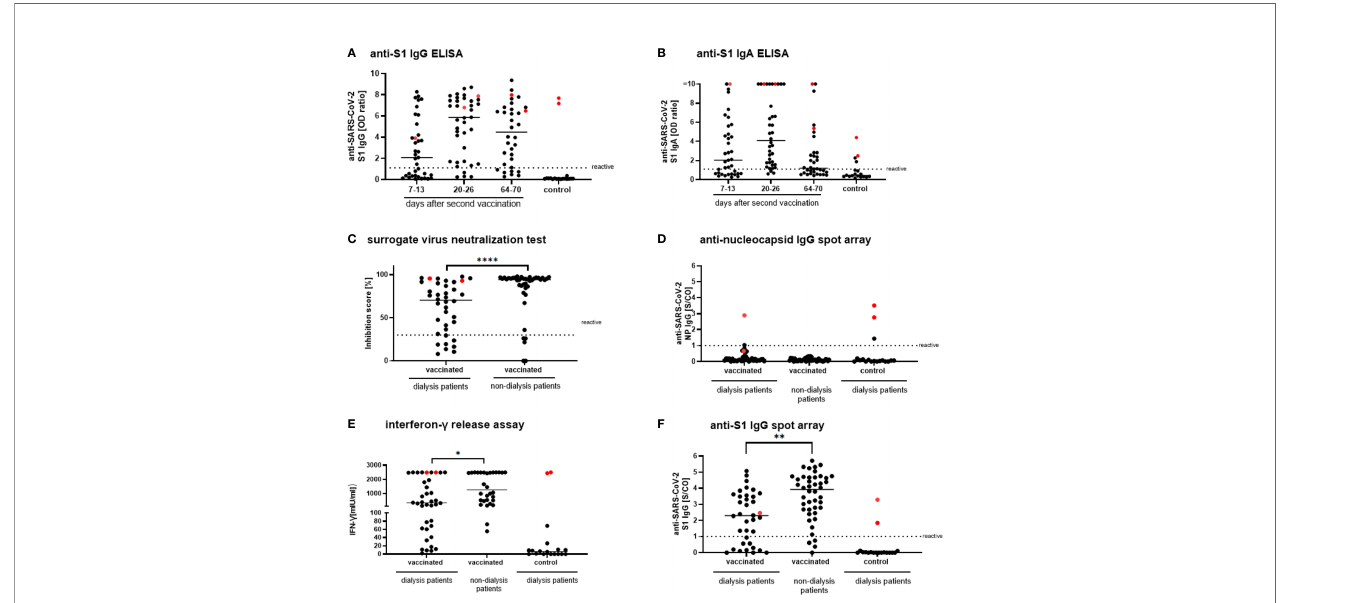
FIGURE 2 | SARS-CoV-2 speci fi c humoral responses in vaccinated and unvaccinated dialysis patients and vaccinated non-dialysis controls. Anti-SARS-CoV-2 S1 IgG and IgA (A, B) were measured in serum of dialysis patients on days 7 – 13 (n = 37), days 20 – 26 (n = 36) and days 64 – 70 (n = 32) after a second dose of Tozinameran (BNT162b2) with unvaccinated dialysis patients as controls (n = 18) using a EUROIMMUN ELISA. Participants with a history of PCR-con fi rmed SARS- CoV-2 infection were shown and marked in red but were excluded from analysis. A surrogate virus neutralization test (C) as well as anti-nucleocapsid IgG (D) were measured 20 – 26 days after the second vaccination in dialysis patients, vaccinated individuals of similar age (n = 44), and unvaccinated dialysis patients (n = 18) utilizing the SeraSpot Anti-SARS-CoV-2 IgG assay and Medac cPass. One vaccinated dialysis patient was excluded as the internal assay control failed. (E) Whole blood from vaccinated and unvaccinated dialysis patients and non-dialysis individuals was stimulated ex vivo with a SARS-CoV-2 S1 peptide pool and IFN- g concentration in the supernatant was measured by ELISA (borderline 45.92; reactive 91.83). SARS-CoV-2 RT-PCR con fi rmed patients are shown in red. Anti-S1 IgG (F) was analyzed along the same line as the cohorts in (D, E) . Horizontal bars depict the median. IgG, Immunoglobulin G; NP, nucleocapsid protein; RBD, receptor binding domain; OD, optical density; S/CO, signal-to-cut-off ratio; IU, international unit. < 0.0001 ****, 0.0001 to 0.001 **, 0.01 to 0.05 *, ≥